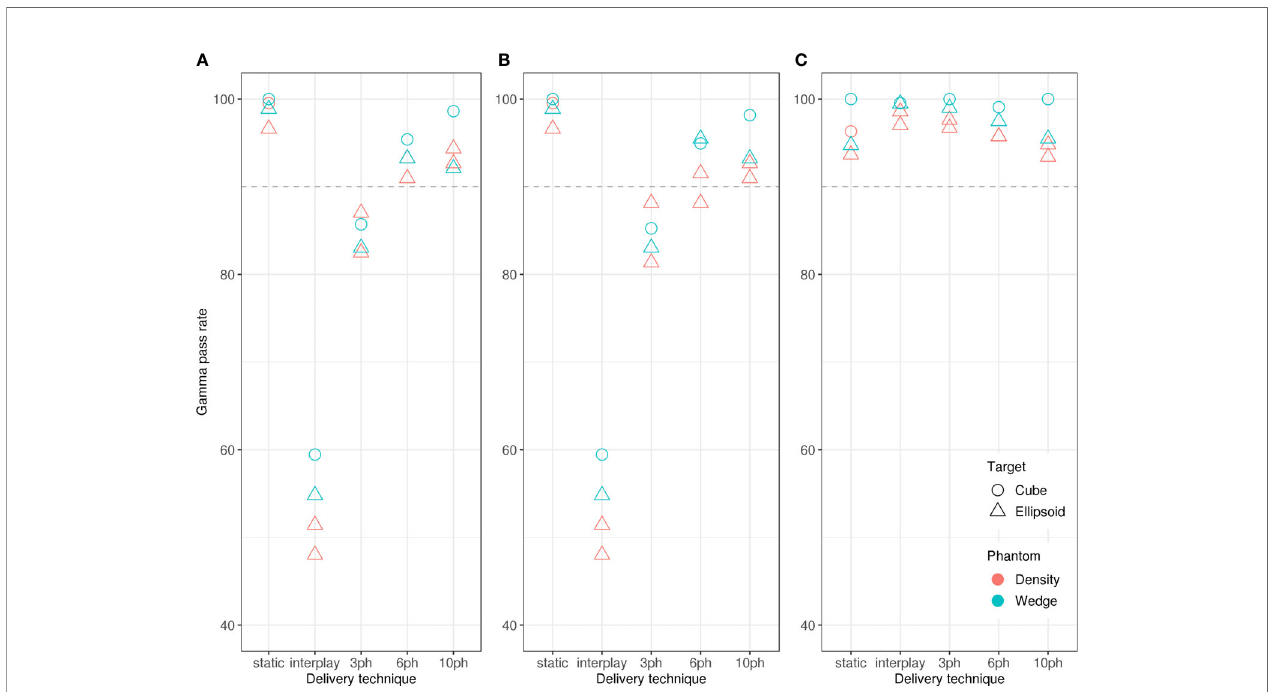
FIGURE 7 | Gamma index analysis pass rates versus beam delivery technique. The pass rates indicate good agreement between measured absorbed dose distributions and (A) reconstructed absorbed dose distributions for the static delivery, (B) planned absorbed dose distributions and (C) reconstructed absorbed dose distributions. Comparisons were made for static deliveries to stationary targets (static), static deliveries to moving targets (interplay), and multi-phase deliveries to moving targets with 3 phases, 6 phases, and 10 phases of motion compensation. Pass rates showed only a weak dependence on phantom type (wedge or density types) and target shape (cube or ellipsoid